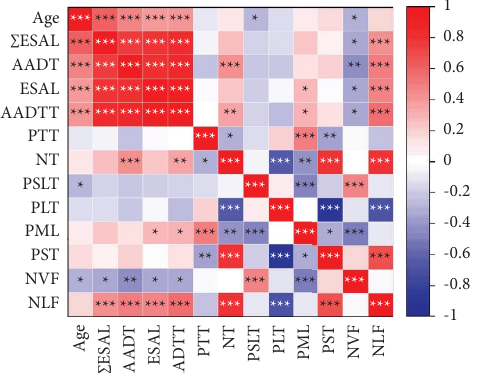
Figure 5: Correlation coefcients between independent variables.